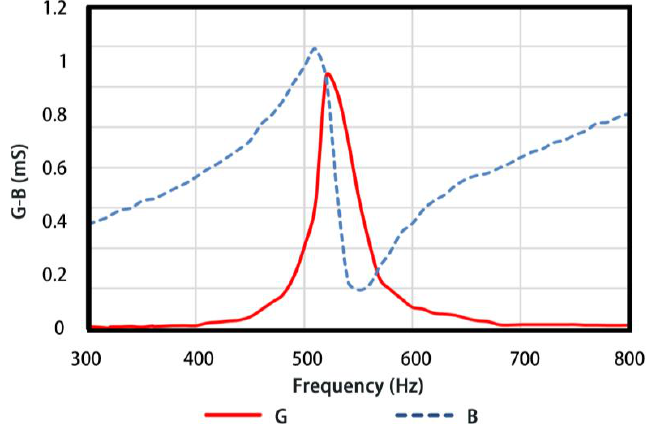
Figure 19. Admittance curves of conformal driving transducers in water.